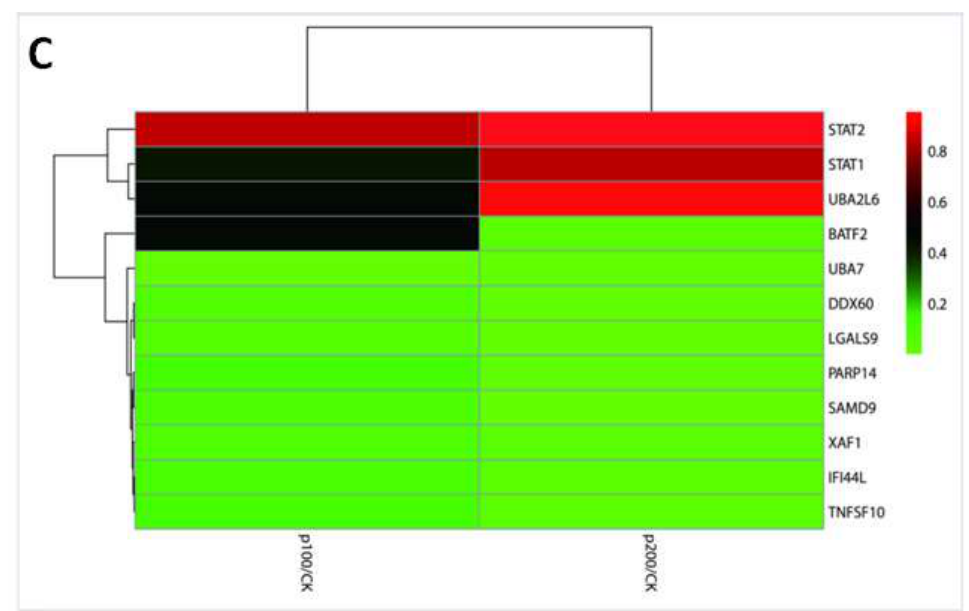
Figure 1. HepG2 cell viability and transcriptomics detection. ( A ) Furosine inhibited cell survival rate with a dose-effect relationship. The data was represented as mean ± SD (standard deviation), * p < 0.05, compared with the control ( n = 8); ( B ) Overlapping of selected genes with changed expressions in control, 100 mg/L group, and 200 mg/L group, through cell transcriptomics detection ( n = 3); ( C ) Heatmap of 12 special genes.